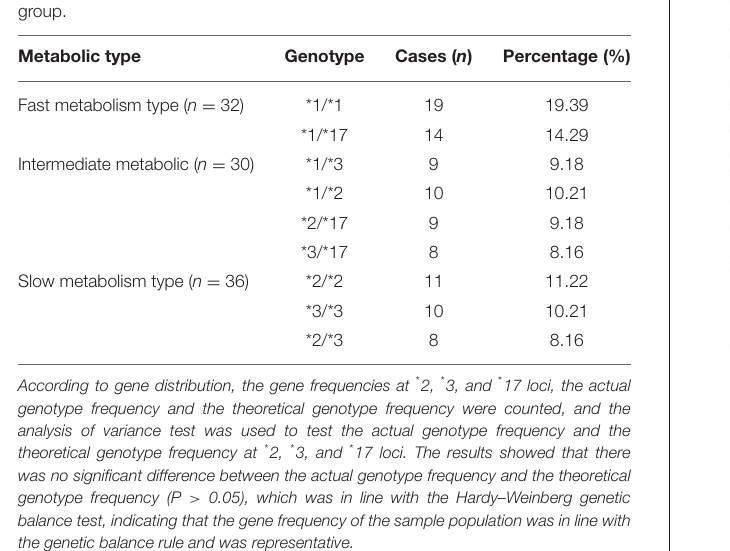
for non-fatal myocardial infarction, and cardiogenic death. Even after standardized DAPT treatment, the probability of